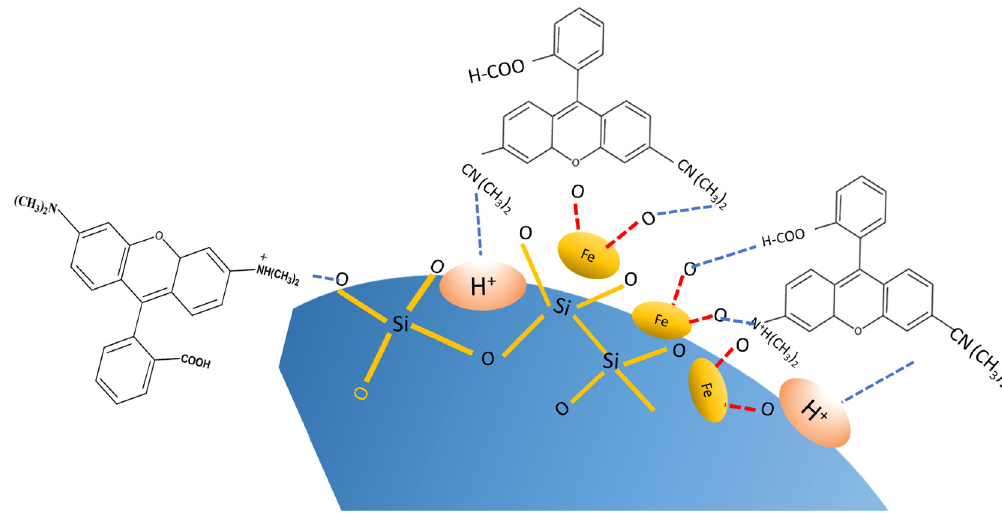
Figure 9: Schematic representation of adsorption mechanism of RhB using Fe 3 O 4 @SiO 2 .